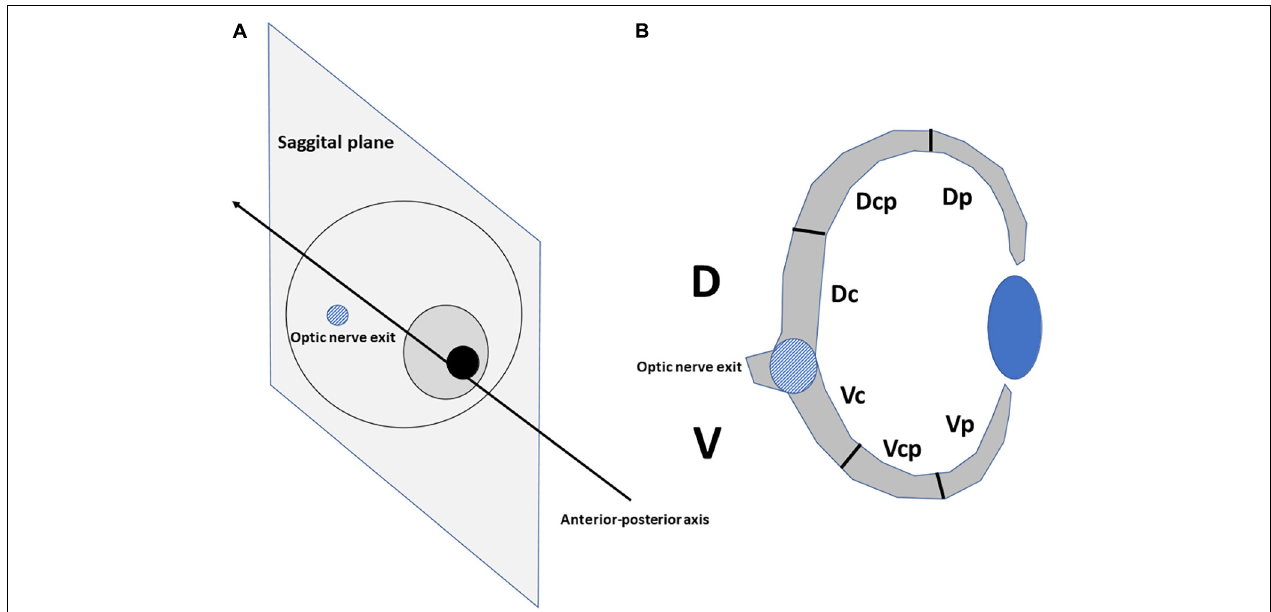
FIGURE 1 | The eyes of bird embryos were cut at the level of the optic nerve exit in the sagittal plane (A) . The dorsal (D) and ventral (V) halves of the retina were divided into sectors into three equally large sectors by measuring the length of the inner limiting membrane (B) : dorso-central (Dc), dorso-centro-peripheral (Dcp), dorso-peripheral (Dp), ventro-central (Vc), ventro-centro-peripheral (Vcp), and ventro-peripheral (Vp).